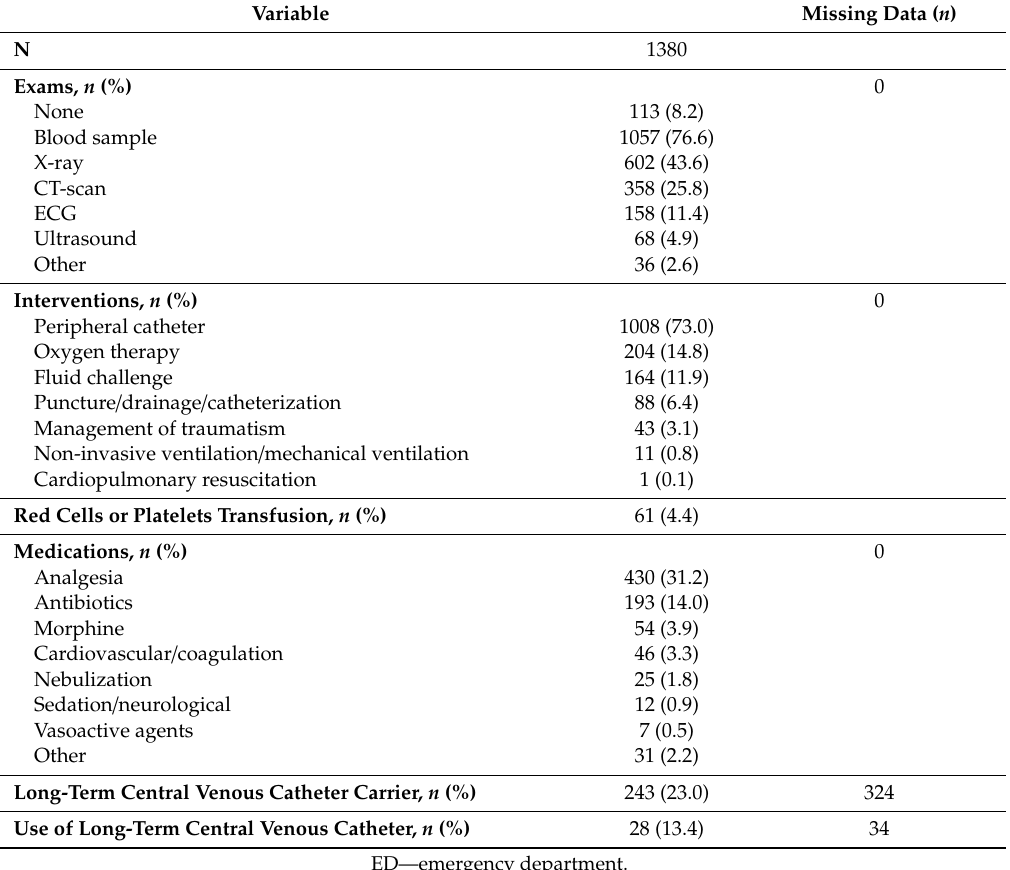
Table 4. Investigations, interventions and treatments performed in the EDs for cancer patients.